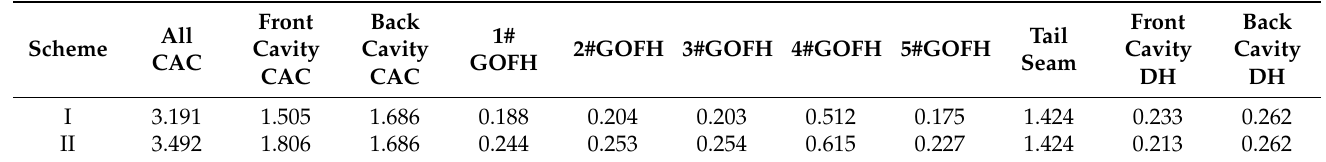
Table 5. Calculated cold air flow results of pipe-network calculation: (The unit is %. CAC, cold air consumption; GOFL, gas output of film hole; DH, dedusting